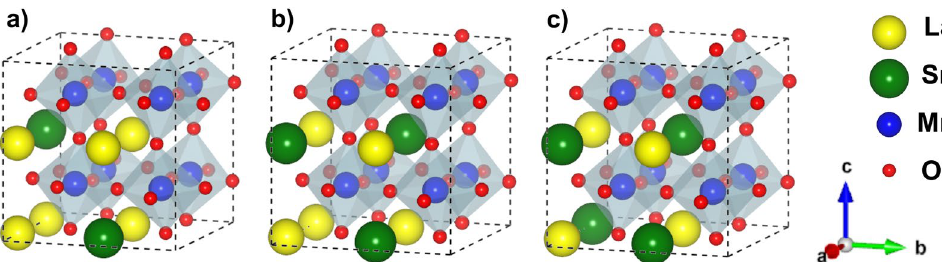
Figure 6. LSMO pseudocubic 2 × 2 × 2 supercells employed in the calculations. ( a ) x = 0.250 , ( b ) x = 0.375 , ( c ) x = 0.500 . Same notation as for Fig. 3.